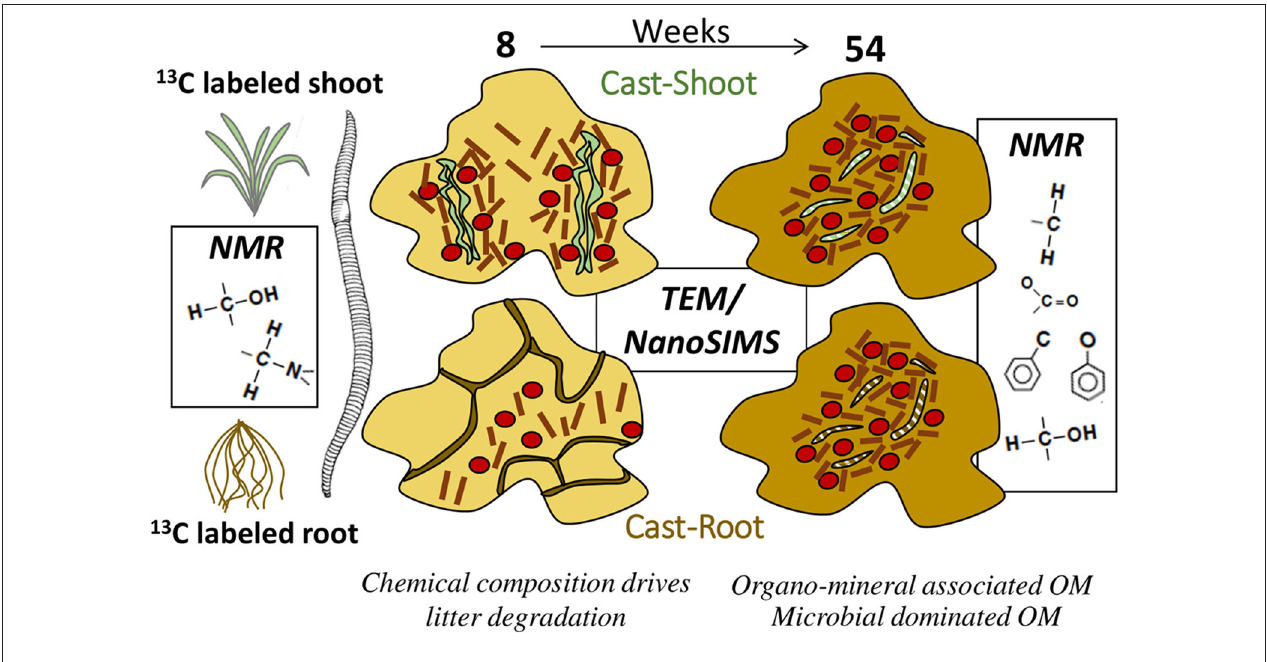
FIGURE 7 | Simplified illustration of the main findings in the present